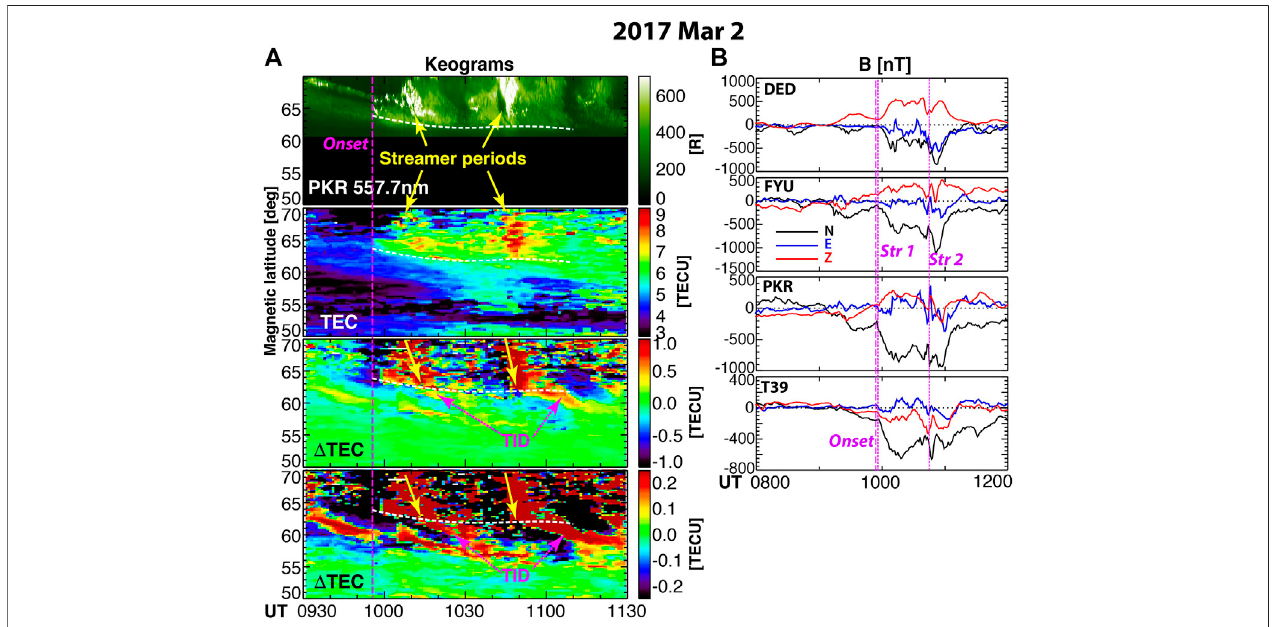
FIGURE 2 | Overview of observations from a period that included a substorm with onset at 0,955:30 UT on March 2, 2017. Keograms on the (A) are, from top to bottom, 557.7 nm emissions from the Poker Flat ASI, vertical TEC, and vertical Δ TEC with two different scales along the PFISR magnetic meridian. Ground magnetometer observations are shown on the panel (B) from stations approximately along the Poker Flat meridian stacked from lower to higher latitudes.